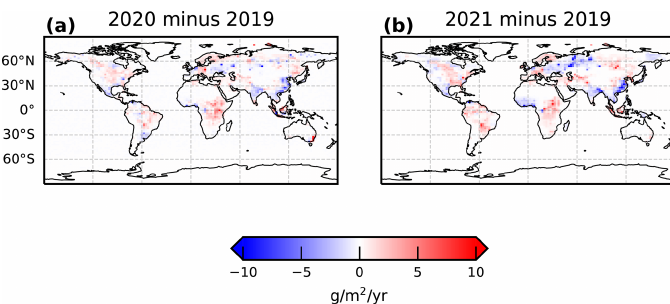
Figure A5. Global a posteriori emissions of methane (gm − 2 yr − 1 ) inferred from GOSAT methane column data for (a) 2020 and (b) 2021.